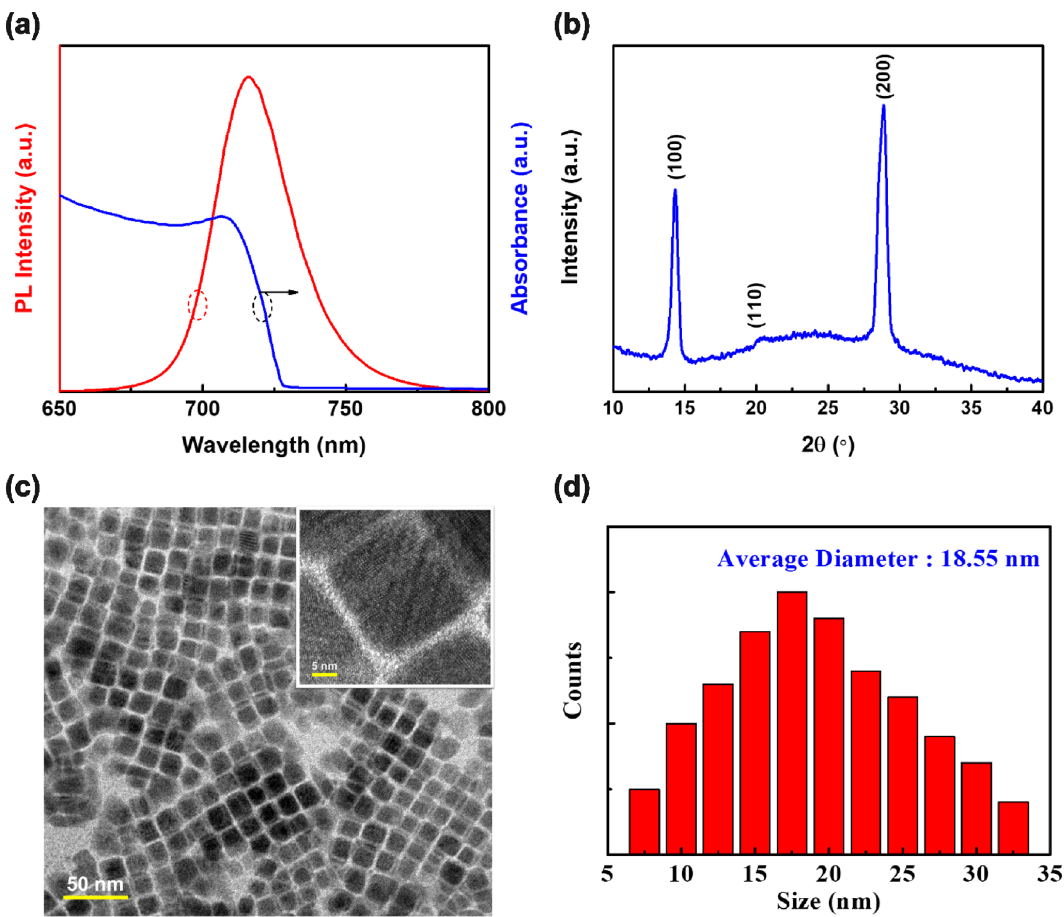
Figure 2. ( a ) Photoluminescence (PL) and absorption spectra, ( b ) XRD pattern, ( c ) TEM image, and ( d ) size distribution chart of CsPbI 3